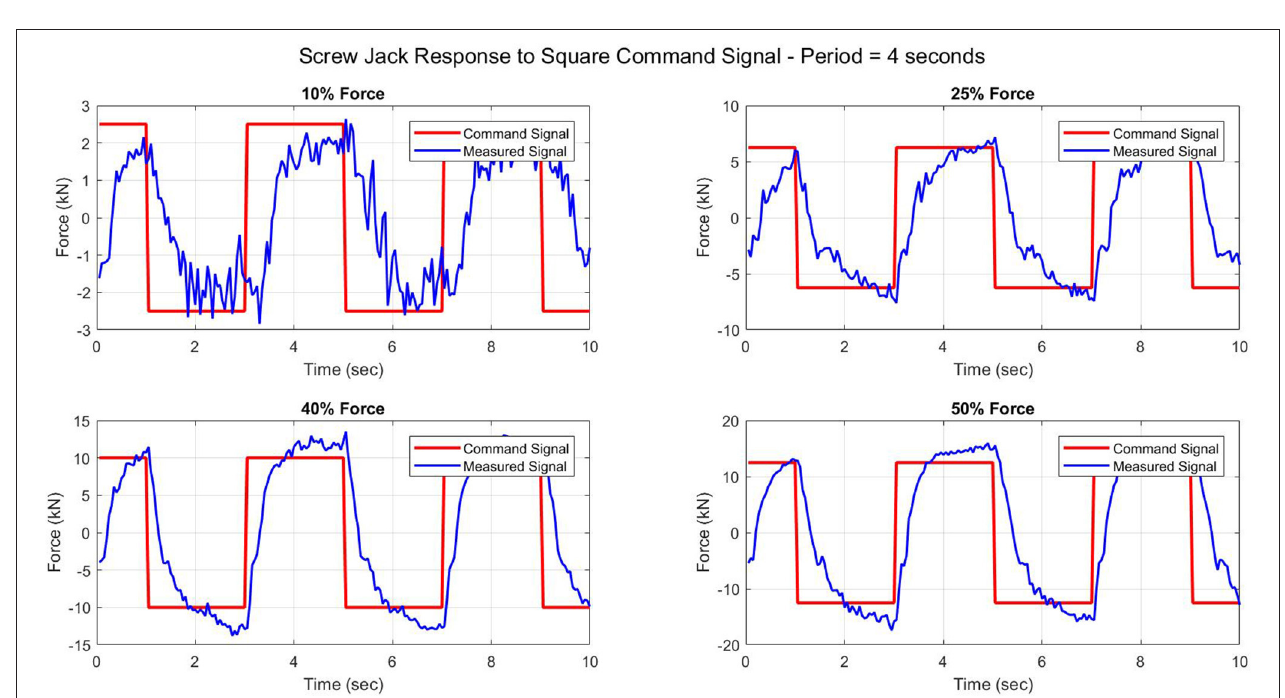
FIGURE 4 | Screw jack characterization tests: square wave force command, period =